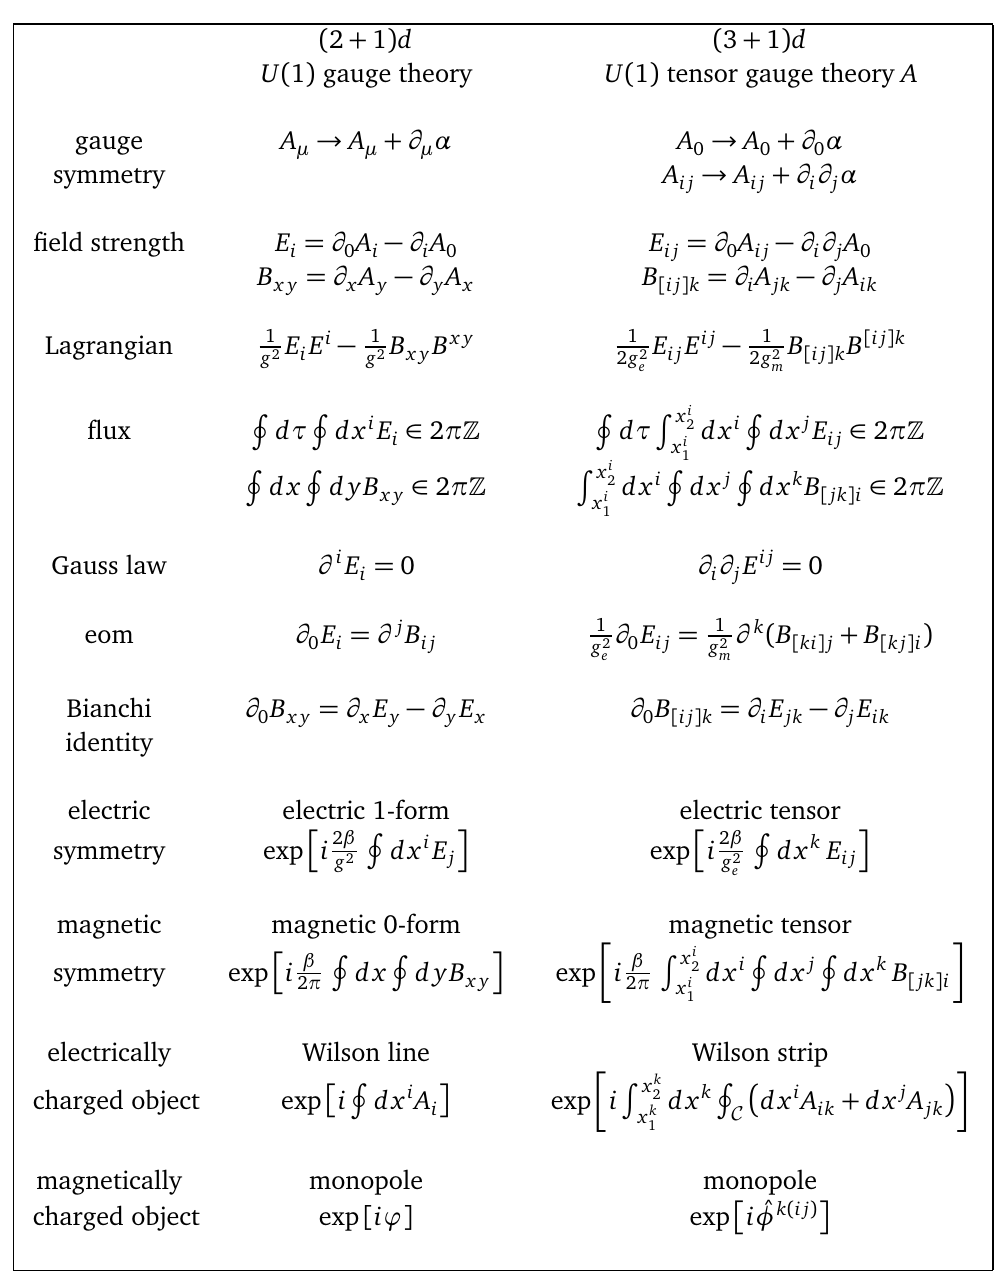
Table 5: Analogy between the 3 + 1-dimensional U ( 1 ) tensor gauge theory A and the ordinary 2 + 1-dimensional U ( 1 ) gauge